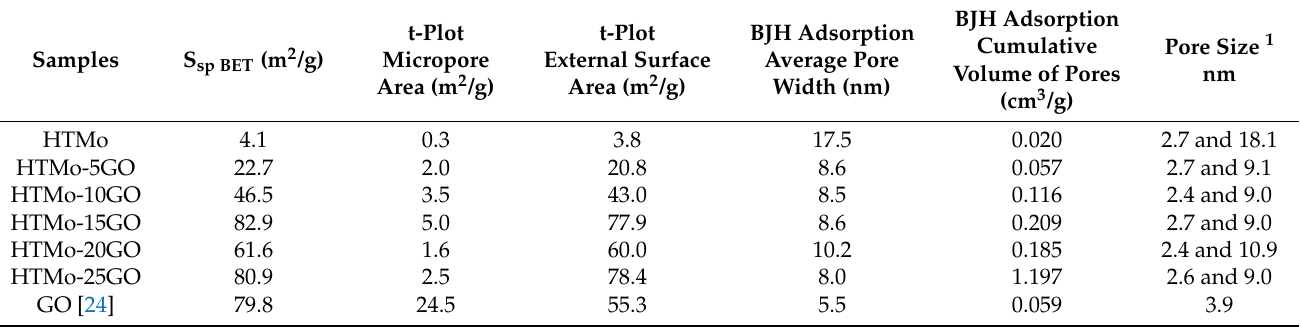
Table 4. Results of the textural analysis using nitrogen adsorption–desorption analysis.